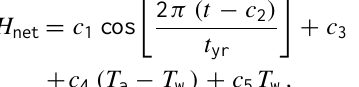
Fig. 3. Lake Superior with the location of the NDBC stations (45004 - Marquette and STDM4 - Stannard Rock) used in this work. The inset shows the location of lake Superior in North America.